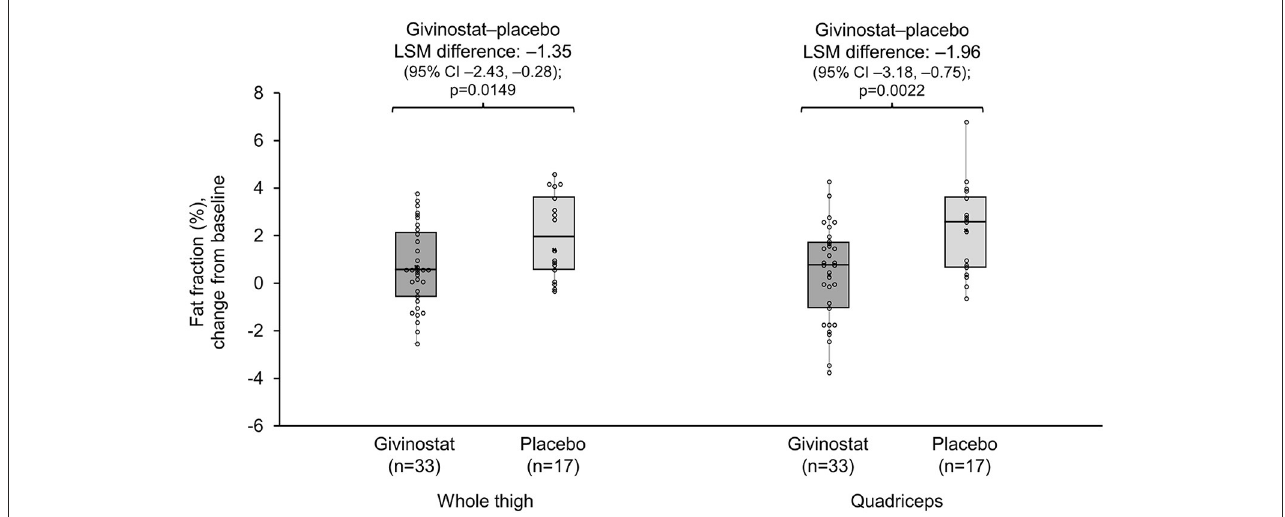
FIGURE2 MRI whole thigh and quadriceps fat fractions change from baseline at Month 12. Data plotted are mean change from baseline (mid-point), interquartile range (box), and range (whisker), with individual patient data overlaid. Mean (SD) whole thigh percentages at baseline were 56.0 (13.78) and 63.5 (13.23) for givinostat and placebo, respectively; baseline quadriceps percentages were 54.7 (15.45) and 60.3 (14.43), respectively. MRI, magnetic resonance imaging; LSM, least squares